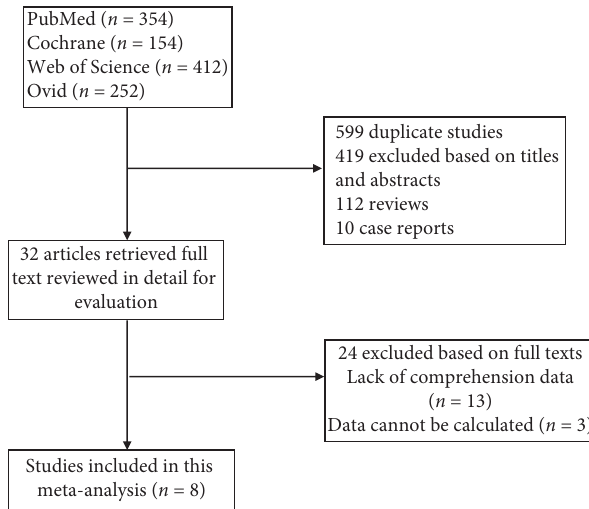
Figure 1: PRISMA